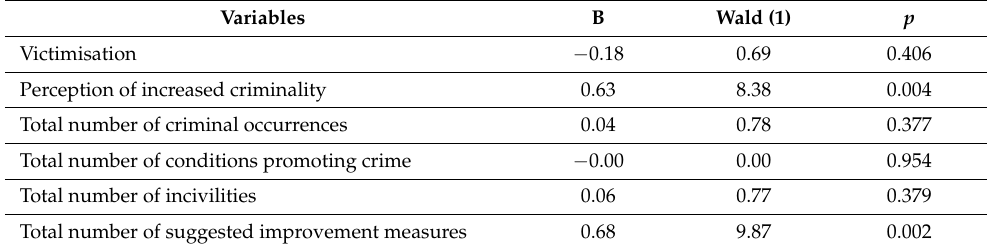
Table 3. Logistic regression for (dis)satisfaction with police performance: results of individual predictors.